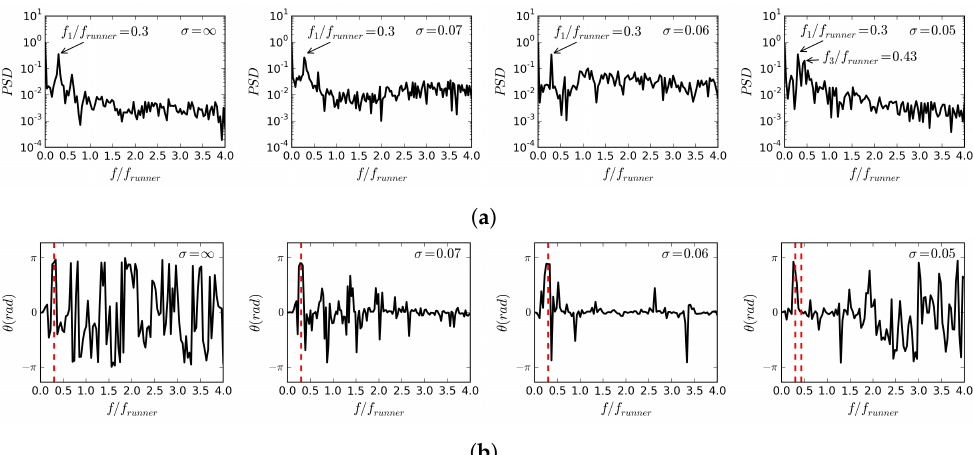
Figure 16. Spectral analysis of the pressure fluctuations in draft tube for different cavitation numbers. ( a ) Frequency analysis of the pressure fluctuations at Probe 2. ( b ) Phase difference between the pressure fluctuations at Probes 2 and